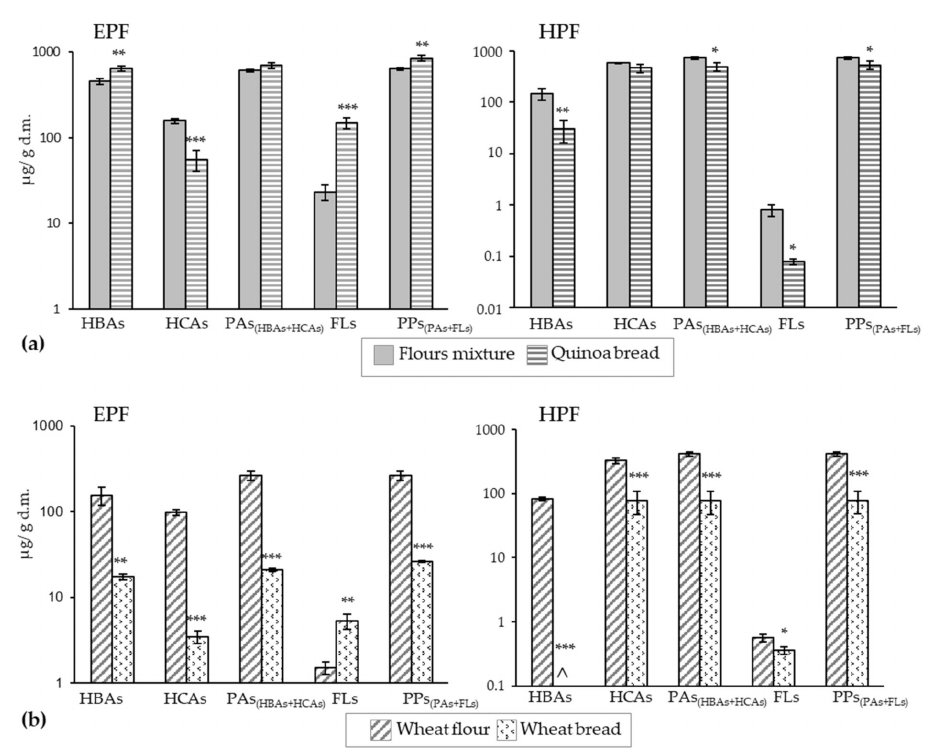
Figure 1. Effect of the bread-making process on the concentration of the different groups of polyphe- nols at the extractable (EFP) and hydrolyzable (HPF) fractions of 25% quinoa bread ( a ) and wheat bread (control) ( b ). Comparisons were always made between the flours mixture (75% wheat + 25% quinoa) and the quinoa bread values ( a ) and between the wheat flour and wheat bread values ( b ) in each group of compounds. Values are the sum of the corresponding individual compounds’ concentrations (Tables 2 and 3). *, **, *** denote significances at p < 0.05, p < 0.01 and p < 0.001, respectively. HBA: hydroxybenzoic acids, HCA: hydroxycinnamic acids, PAs: phenolic acids, FLs: flavonoids, PPs: polyphenols, ˆ not